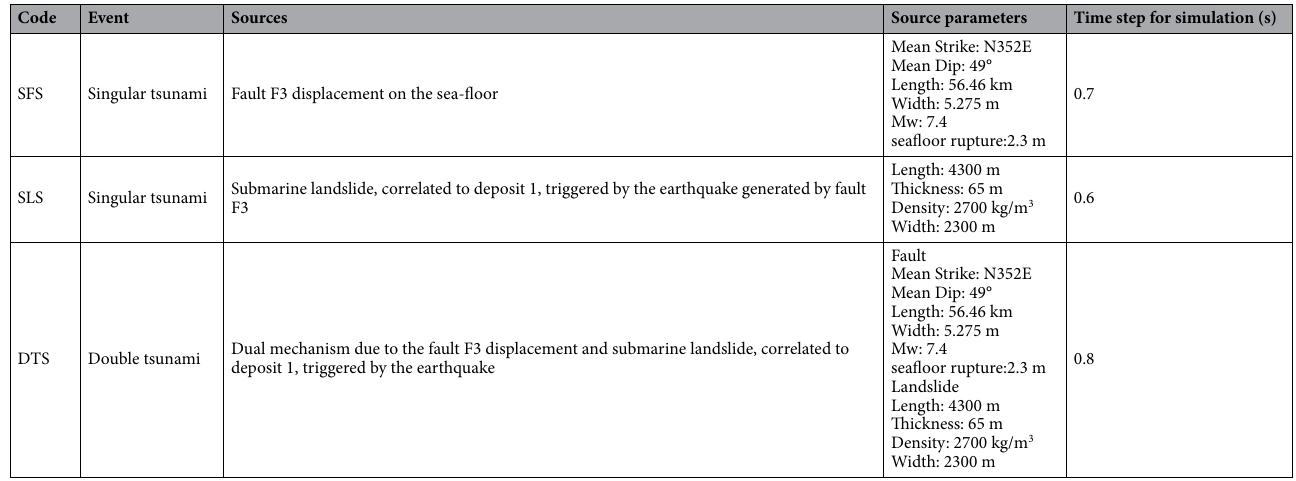
Table 2. Modelled scenario in GEOWAVE with reported typology of the event, sources and their